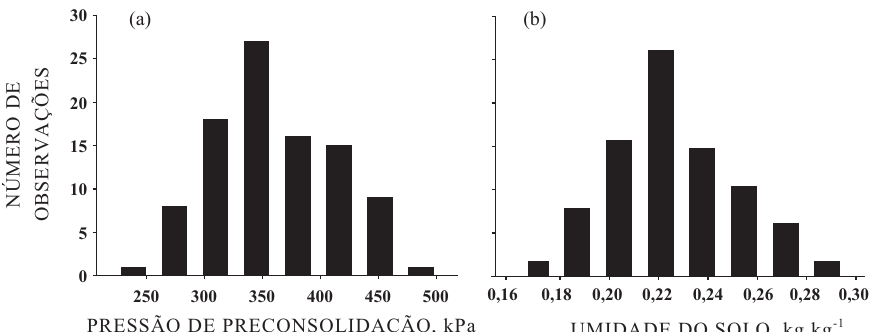
Figura 3. Distribuição de freqüência para as 98 amostras de pressão de preconsolidação (a) e umidade do solo (b).